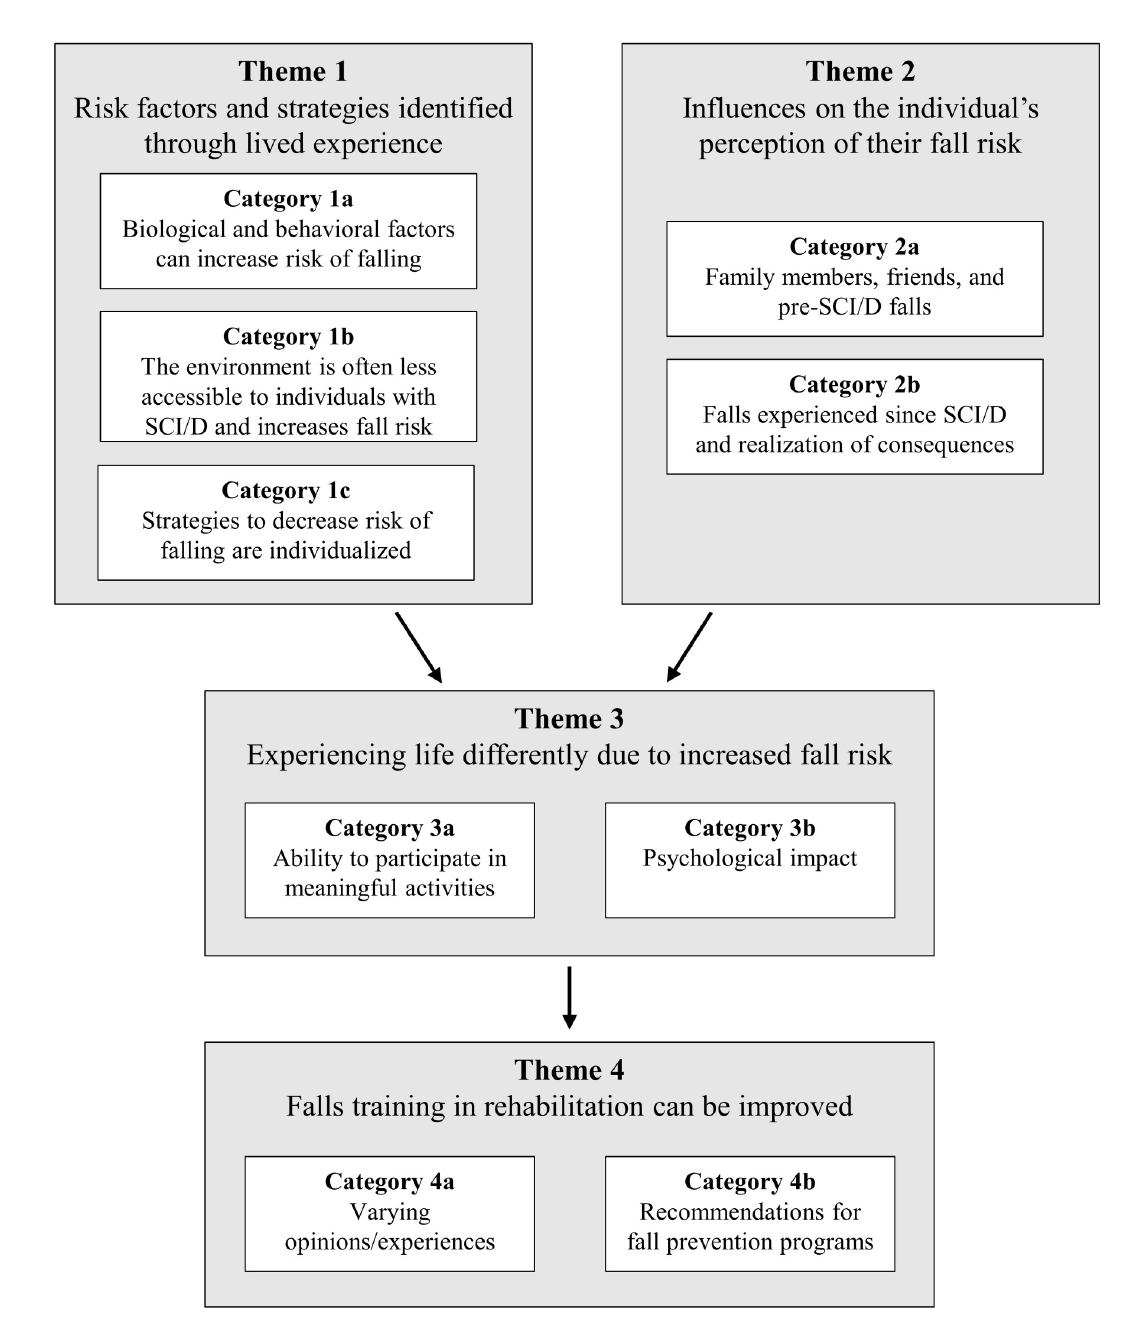
Fig 1. Themes and categories. Four main themes concerning falls and fall risk during the subacute phase of SCI/D are shown along with the categories within each theme. Risk factors and strategies identified through lived experience (Theme 1) and Influences on the individual’s perception of their fall risk (Theme 2) lead to Experiencing life differently due to increased fall risk (Theme 3). Based on these lived experiences, participants felt that Falls training in rehabilitation can be improved (Theme 4).